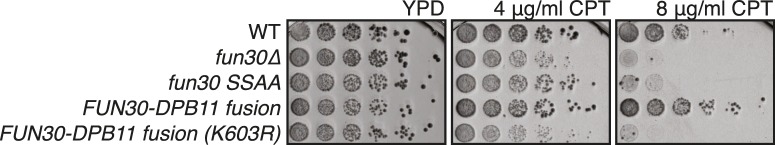
The catalytic activity of Fun30 is required for the suppression of the CPT phenotype in the context of the FUN30-DPB11 fusion.Spotting of strains with indicated genotypes in 5-fold serial dilutions on CPT containing medium. The K603R mutation is located in the Walker A motif of Fun30. Plates were incubated for two days at 37°C.